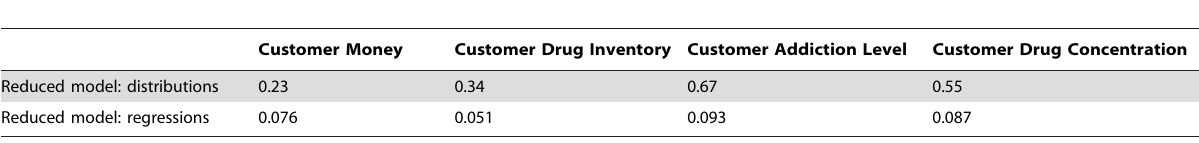
Table 1. Results of two-sample Kolmogorov-Smirnov tests for both versions of the reduced model.